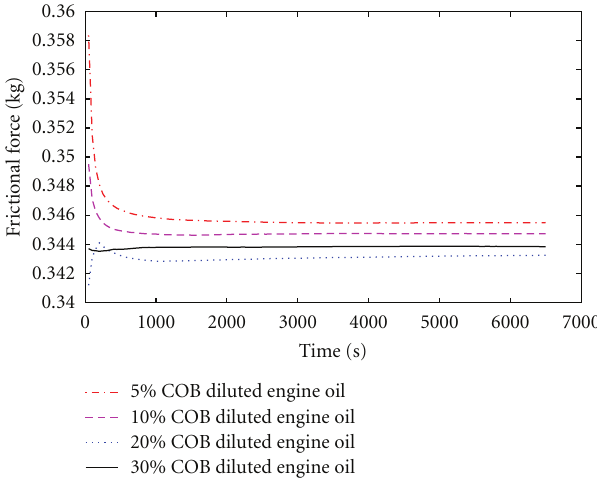
Figure 3: Friction force versus time for canola oil biodiesel and engine oil mixtures.